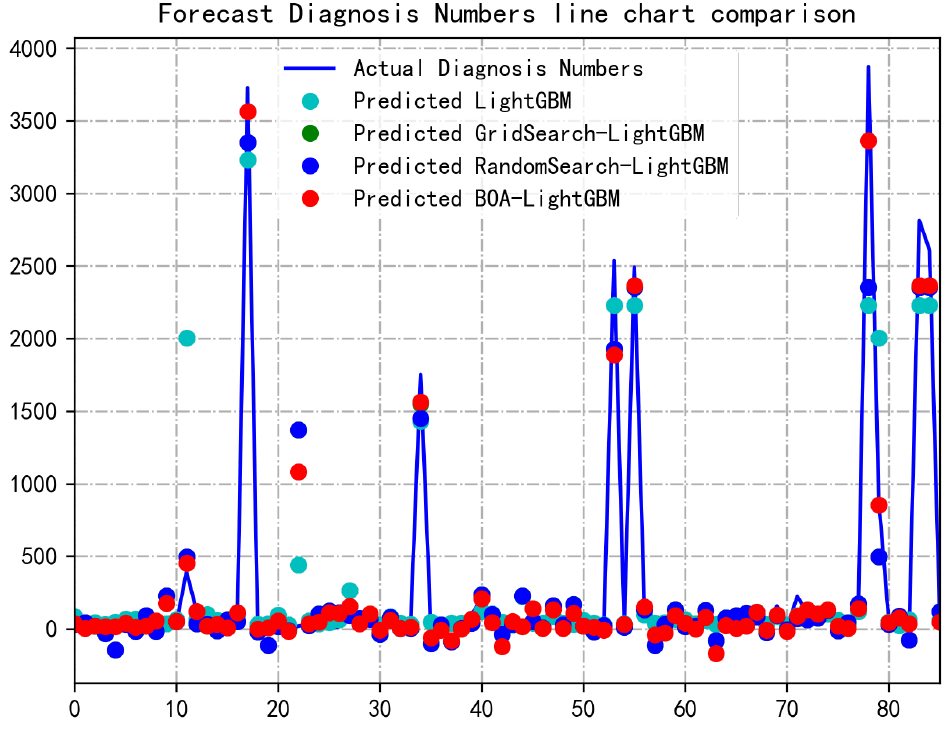
Figure 10. Comparison of predicted and true values of the four models. BOA, Bayesian optimization algorithm; GBM, gradient boosting